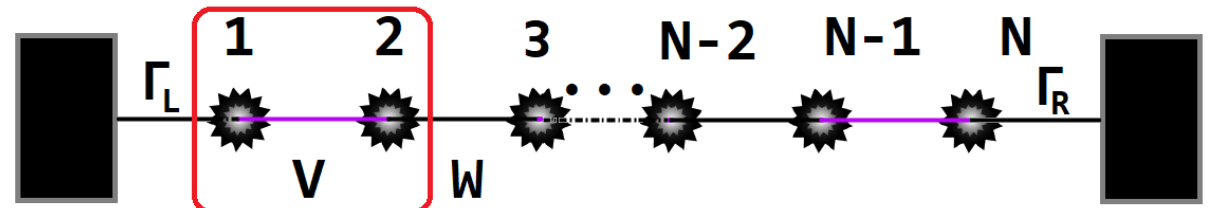
Figure 1. Model of atomic SSH chain composed of N sites on the insulating surface (which can stand for a gate electrode). The nearest-neighbor couplings between sites are denoted by V and W and the couplings with the left and right electrodes represent Γ L / R